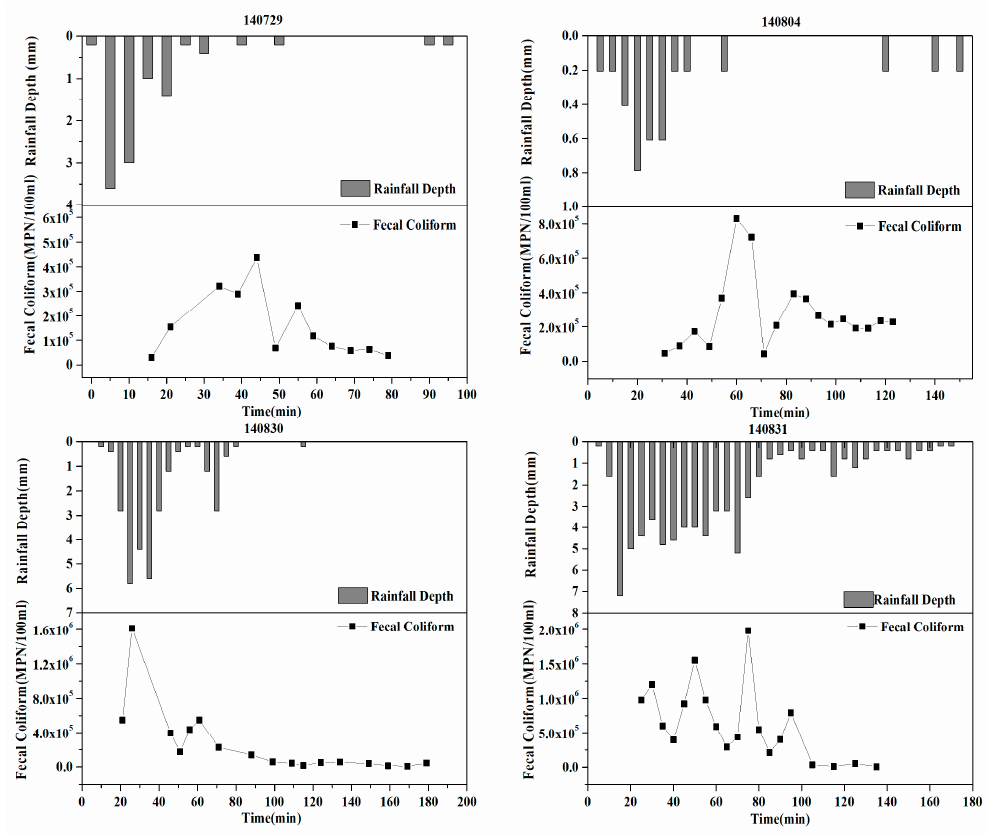
Figure 2. Time distribution of instantaneous concentration of FC in the sewer outlet.